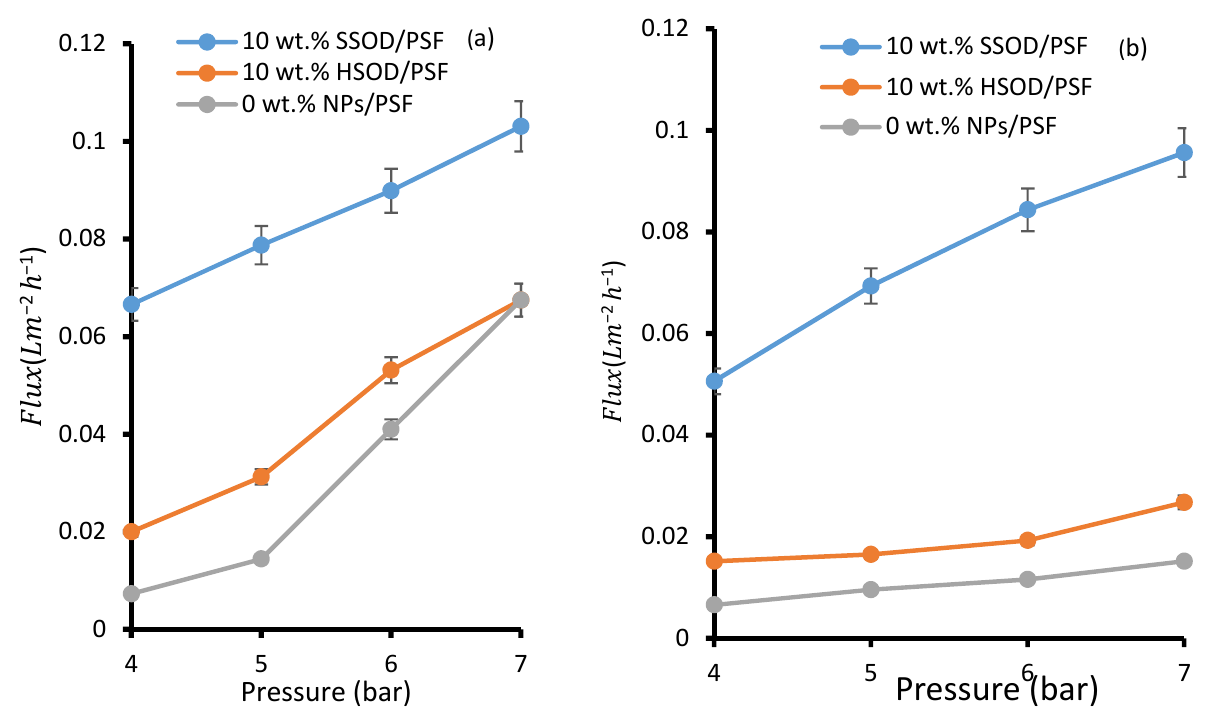
Figure 9. Membrane flux: ( a ) pure water flux and ( b ) phenol-containing